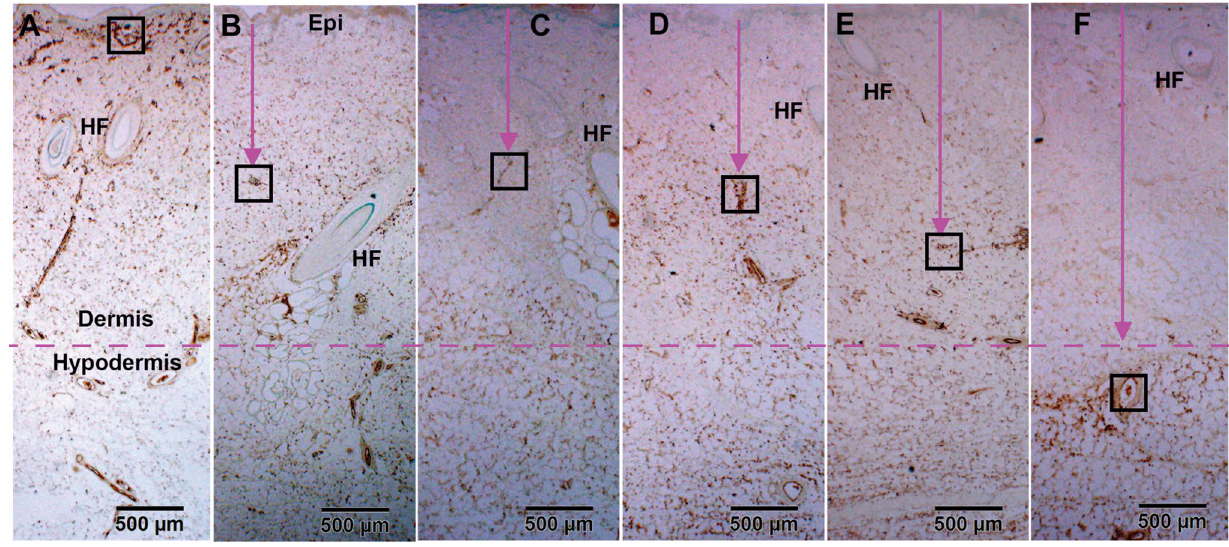
Figure 5. Representative vimentin IHC micrographs of burn sites of porcine burn wounds harvested at 0 h ( A ), 0.5 h ( B ), 1 h ( C ), 2 h ( D ), 4 h ( E ), 24 h ( F ). The box in each time point was outlined to locate the highest vertical (from epidermal basement) levels of positive vimentin staining at that time point. High power images of the outlined boxes are presented in Fig. 6. Epi, epithelium. HF, hair follicle. Bar = 500 µm ( A to F ).